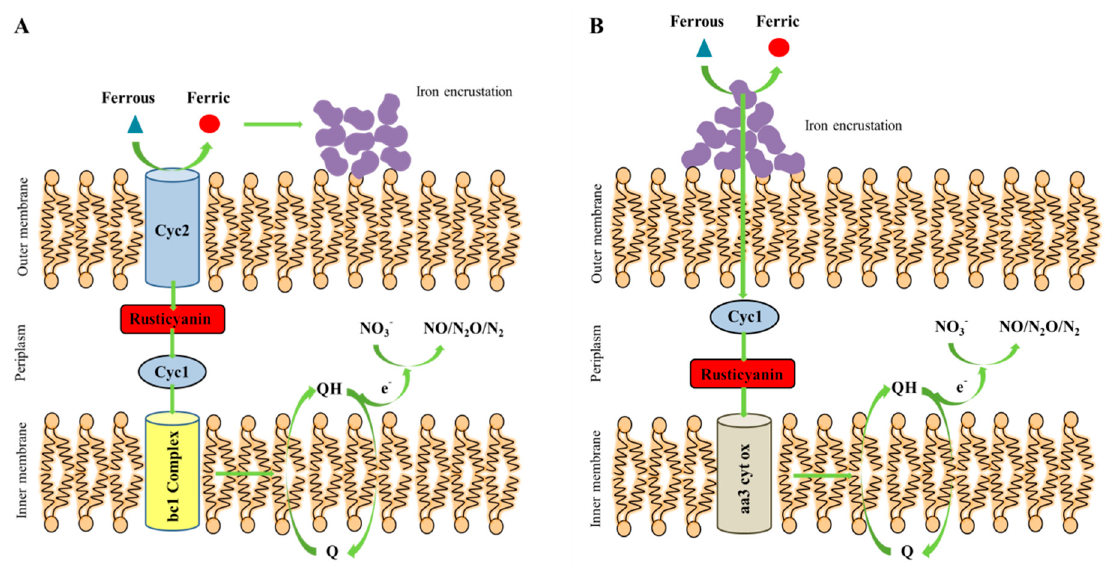
Figure 5. The conceptual autotrophic denitrification mechanisms by Shewanella sp. strain F1. The tiled iron encrustation was formed as shown in ( A ), while the towery iron encrustation was formed as shown in ( B ).